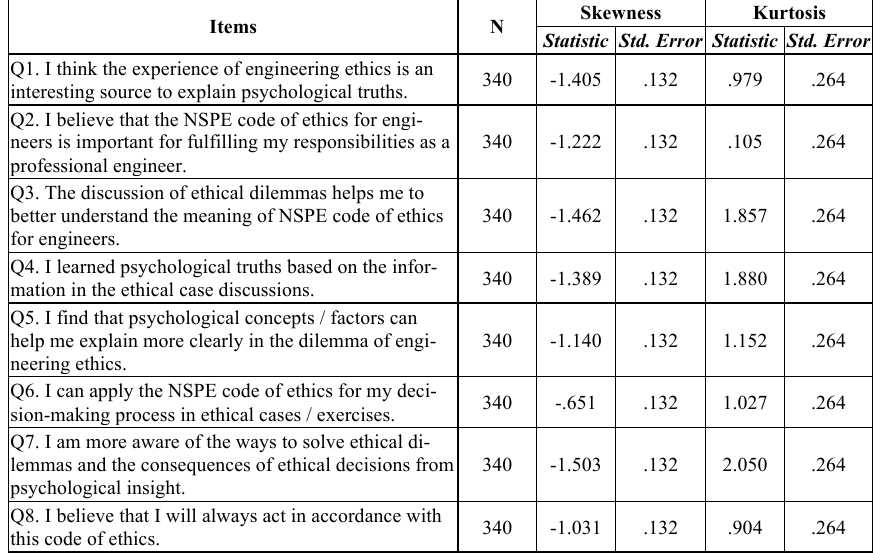
Table 6. Skewness test and Kurtosis test of the data on student feedback Skewness Kurtosis Items N Statistic Std. Error Statistic Std.